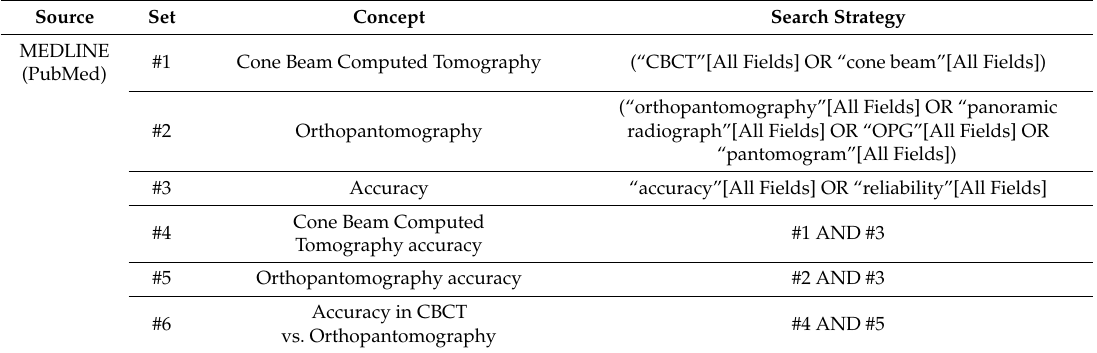
Search strategy for articles comparing Cone Beam Computed Tomography (CBCT) vs. Orthopantomography (OPG) in dental anatomy